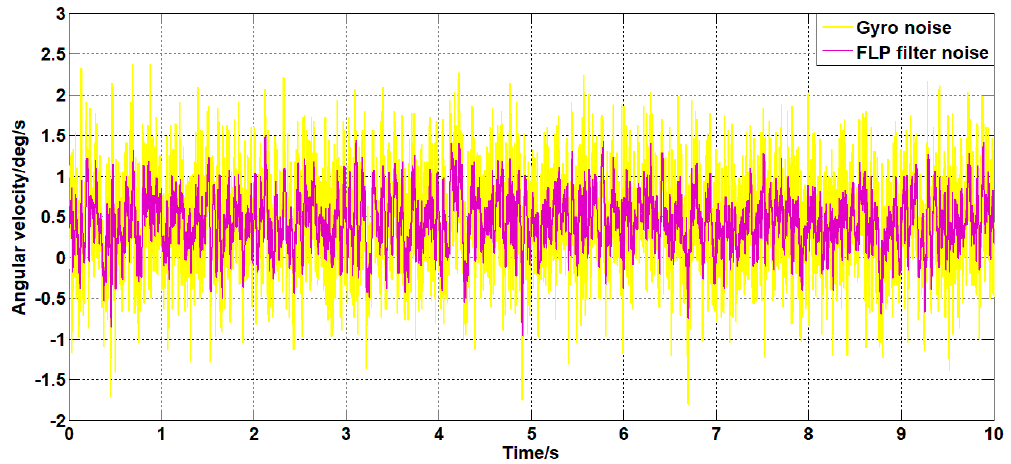
Figure 19. The angular velocity curve filtered by a forward linear algorithm.